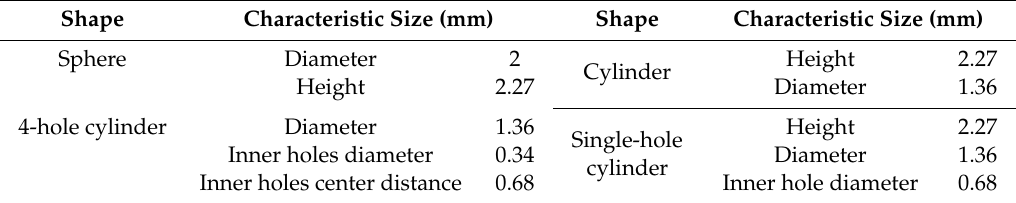
Figure 2. Illustration of four simulated packing meshes including sphere ( a ), cylinder ( b ), single-hole cylinder ( c ), and 4-hole cylinder ( d ). Table 2. Geometric size of four kinds of